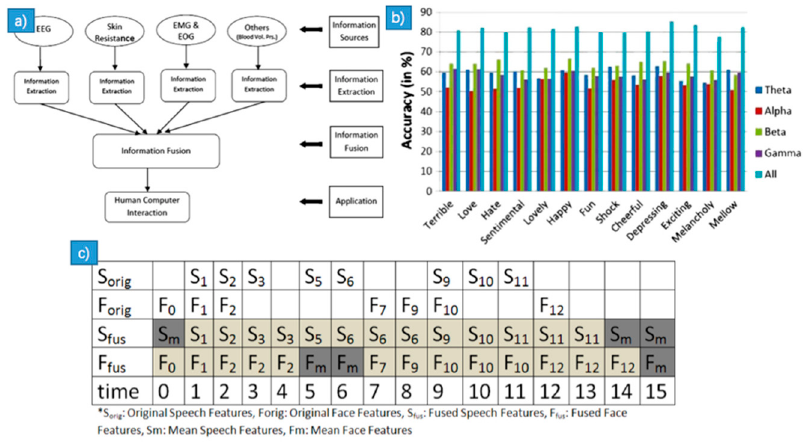
Figure 12. ( a ) Typical framework of multimodal information fusion; ( b ) SVM results for different emotions with EEG frequency band; ( c ) Demo of the proposed feature level fusion. A feature vector created at any time step is valid for the next two steps.